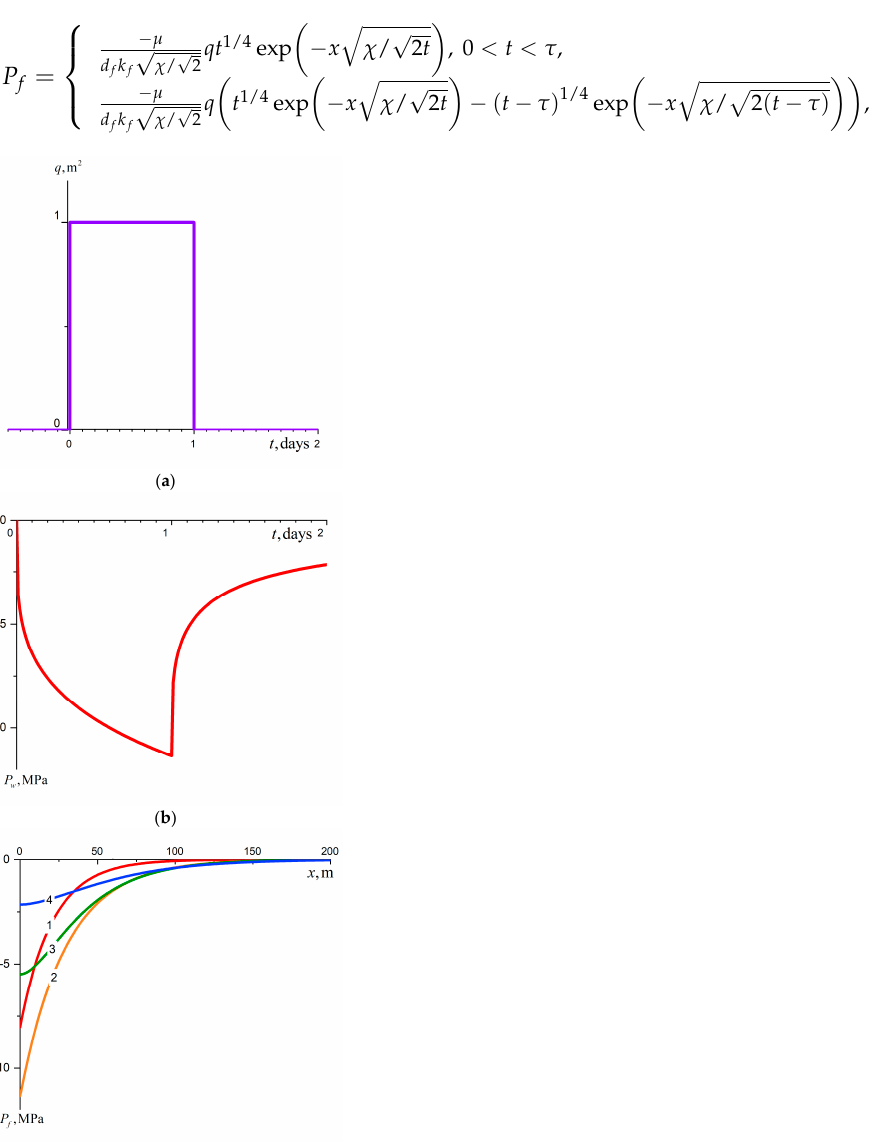
Figure 2. ( a ) ∏ -shaped change in debit; ( b ) well-pressure change; ( c ) pressure evolution in hy- draulic